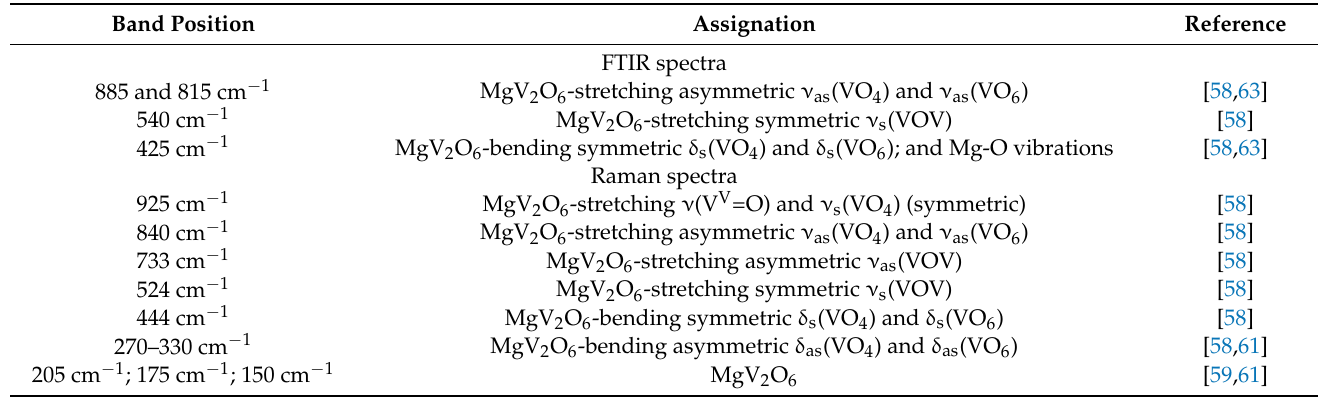
Table 2. Assignation of the FTIR and Raman spectral bands of the MgVO-LT material.